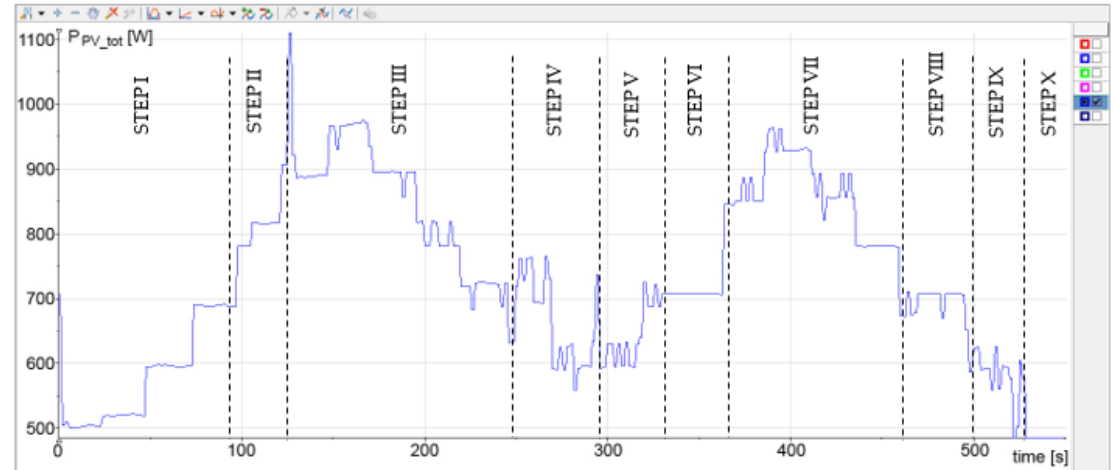
Figure 12. Power absorbed from critical loads. Energies 2018 , 11 , x FOR PEER REVIEW